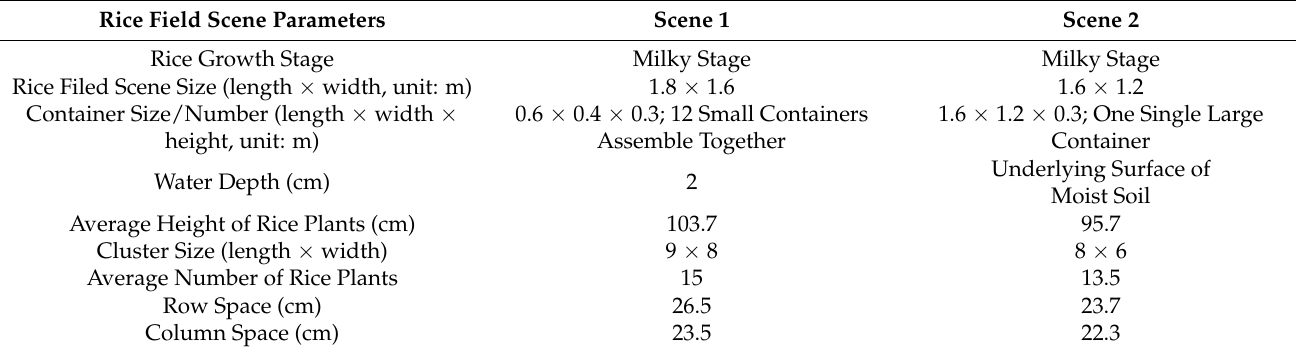
Table 1. Layout parameters of two rice field scenes.